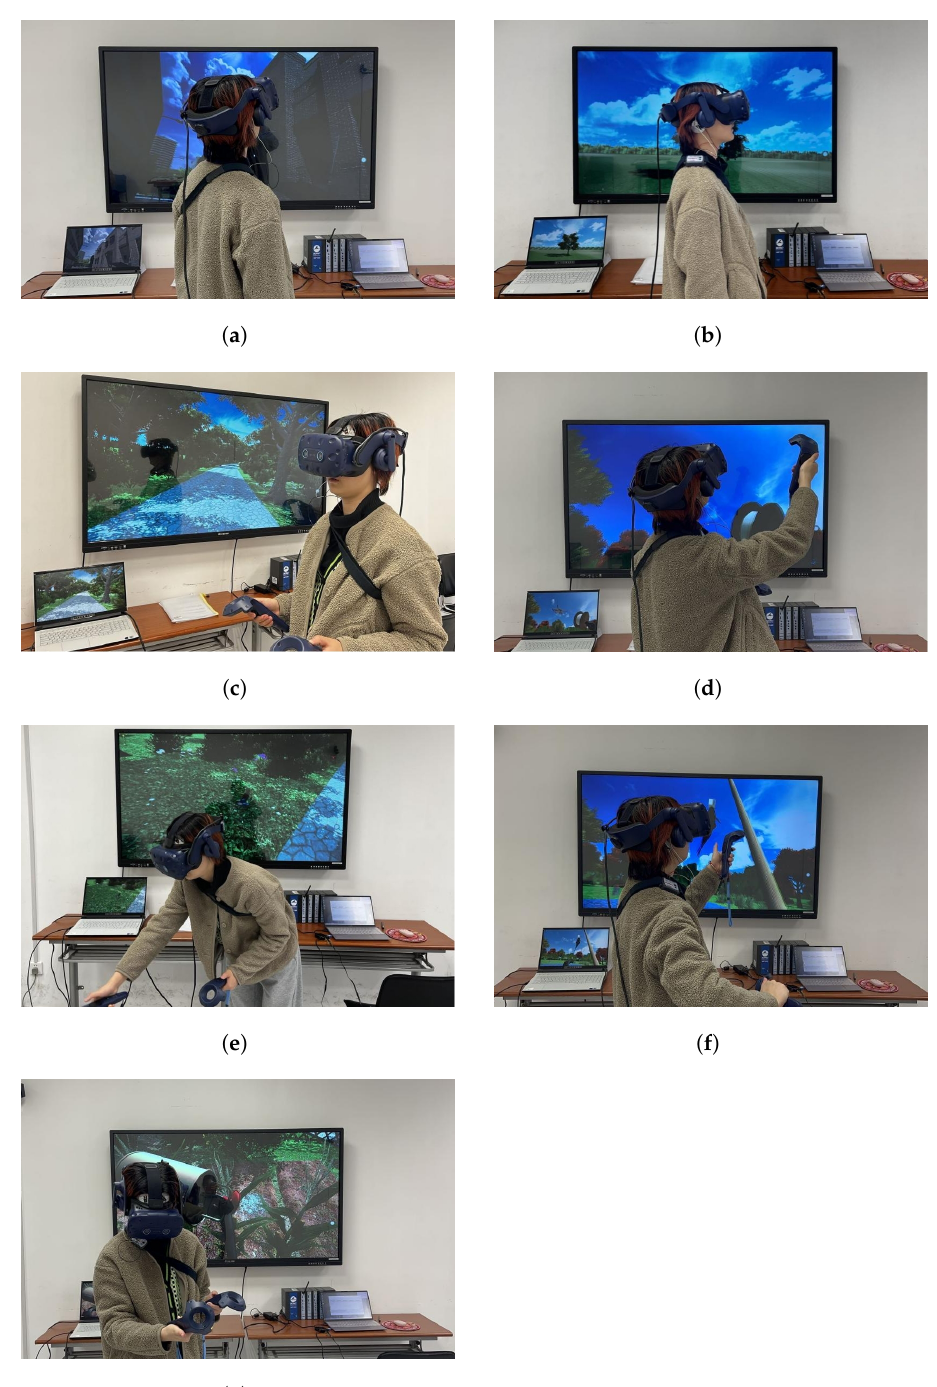
Figure A2. Examples of experimental scenarios. ( a ) Participants experience the urban scene with- out interaction. ( b ) Participants experience the garden scene without interaction. ( c ) Participants experience the restorative interaction scene. ( d ) Activity 1 of the restorative interaction scene: flying a kite. ( e ) Activity 2 of the restorative interaction scene: feeding the birds. ( f ) Activity 3 of the restorative interaction scene: fishing. ( g ) Activity 4 of the restorative interaction scene: watering the